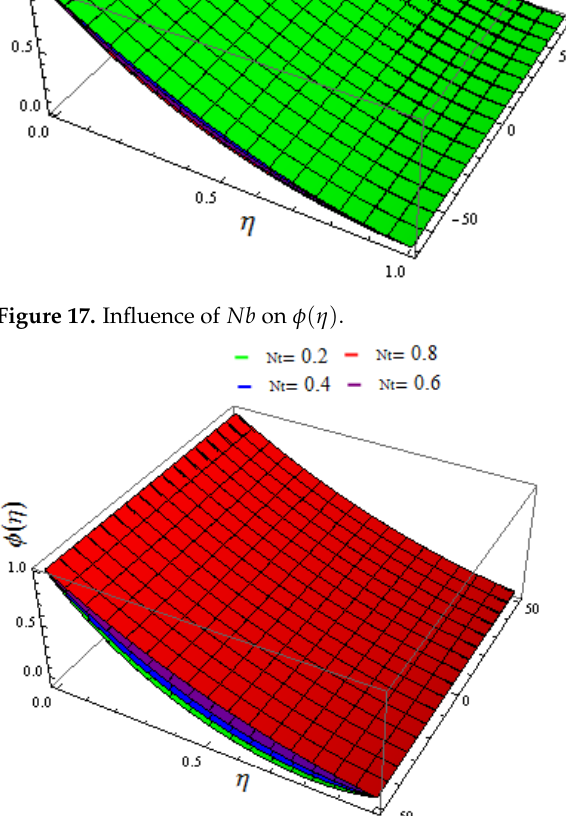
Figure 18. Influence of Nt on φ ( η ) .